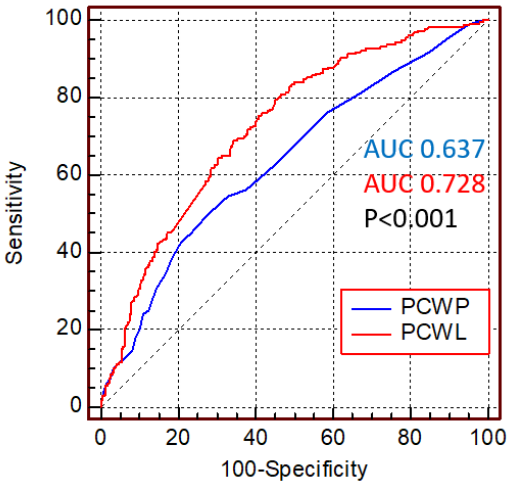
Figure 1. Diagnostic properties of pulmonary capillary wedge pressures at rest and during exercise to predict survival. Receiver operating curve analysis comparing the diagnostic properties of pulmonary capillary wedge pressure at rest (PCWP, in blue) and pulmonary capillary wedge pressure during exercise, expressed as peak exercise to workload normalized to body weight (PCWL, in red). ROC curves were compared using the previously reported method by DeLong et al.